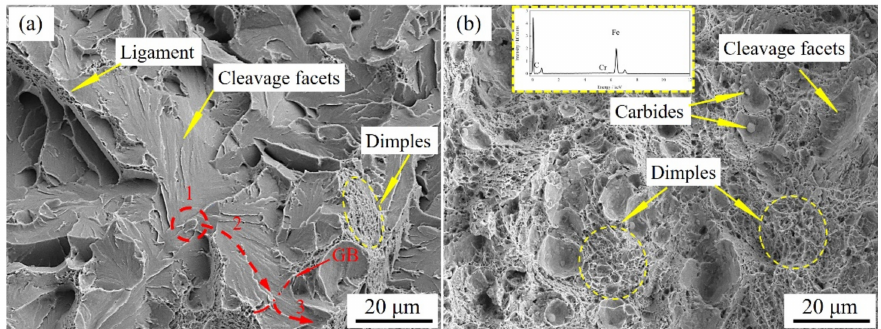
Figure 6. SEM micrographs of the fracture surface of impact samples, ( a ) NT; ( b ) QT. 1: grain 1; 2: grainn 2; 3: grain